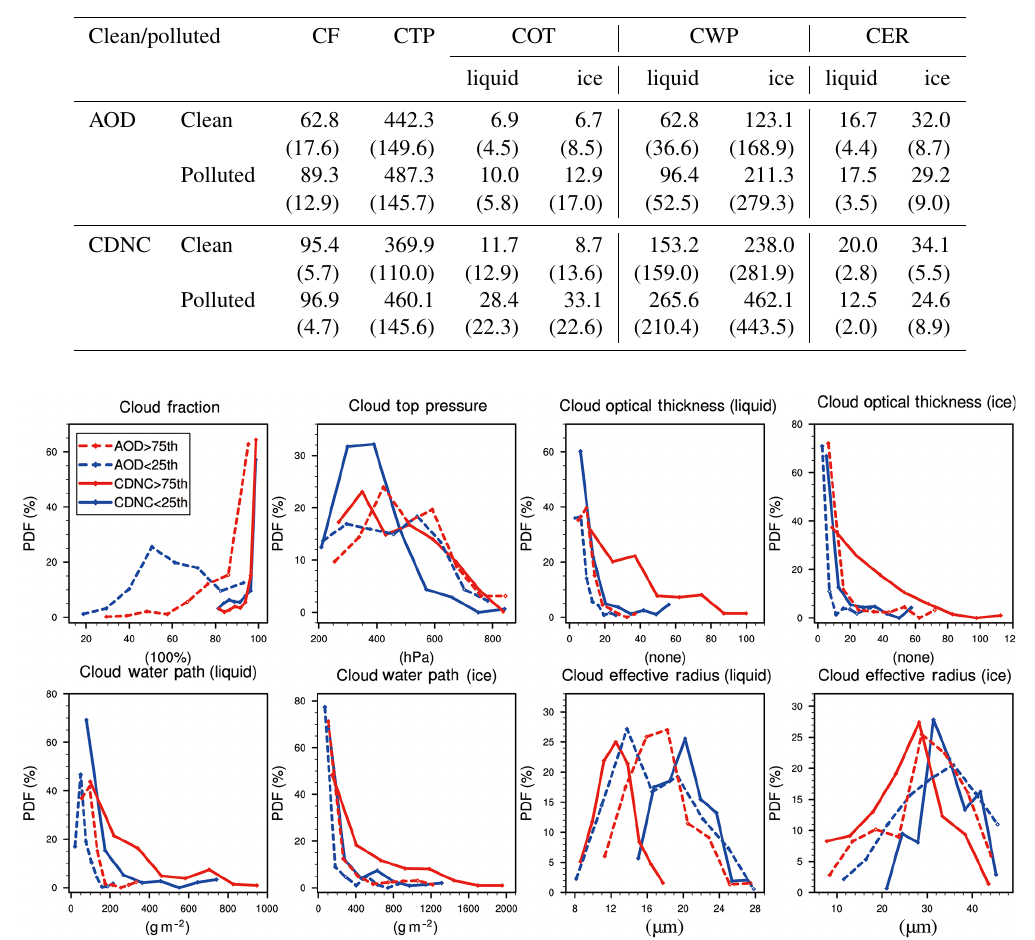
Table 4. The mean values of CF (units: %), CTP (units: hPa), COT (liquid and ice, units: none), CWP (liquid and ice, units: gm − 2 ) and CER (liquid and ice, units: µm) from the MODIS C6 cloud product on the clean condition (less than the 25th percentile) and polluted condition (more than the 75th percentile) using two indicators of AOD and CDNC. Numbers in the brackets stand for the standard deviations on the means. The differences between clean and polluted conditions have all passed the significance test of 95%.